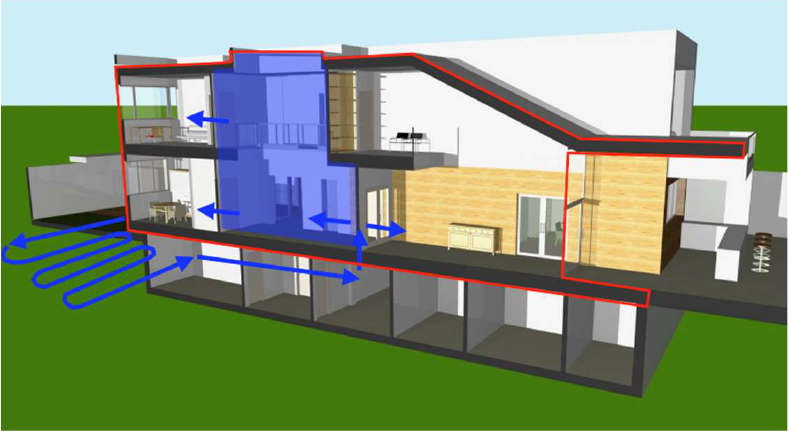
Figure 12. Layout of the LEGE system in Casa Zaranda.